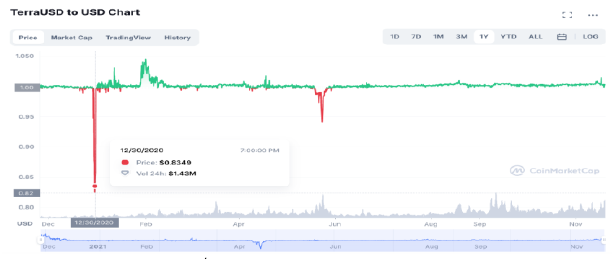
Figure 4. The Terra/Luna crash. Source: [16]